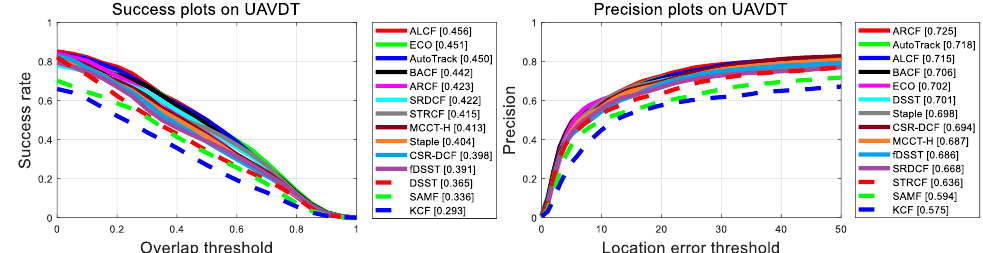
Figure 7. Overall performance of ALCF and other state-of-the-art trackers on DTB70.